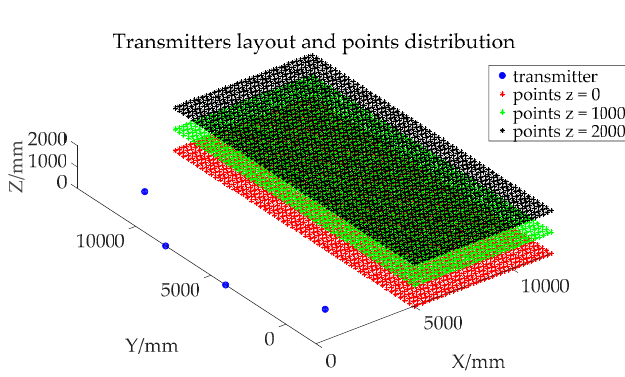
Figure 7. Points distribution in the measurement zone.